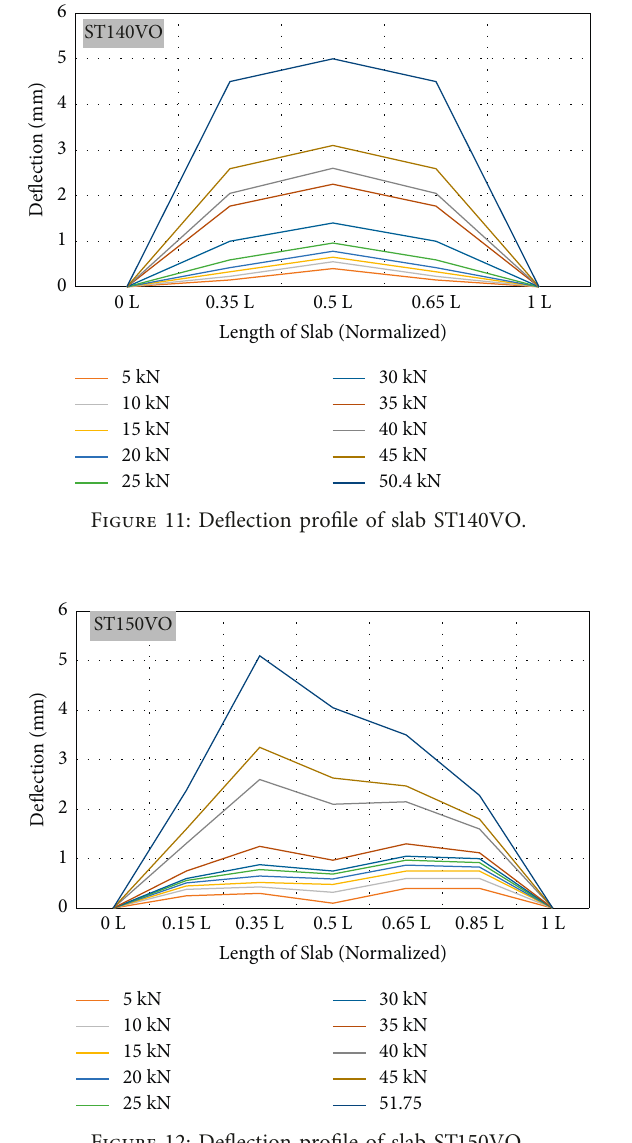
Figure 12: Deflection profile of slab